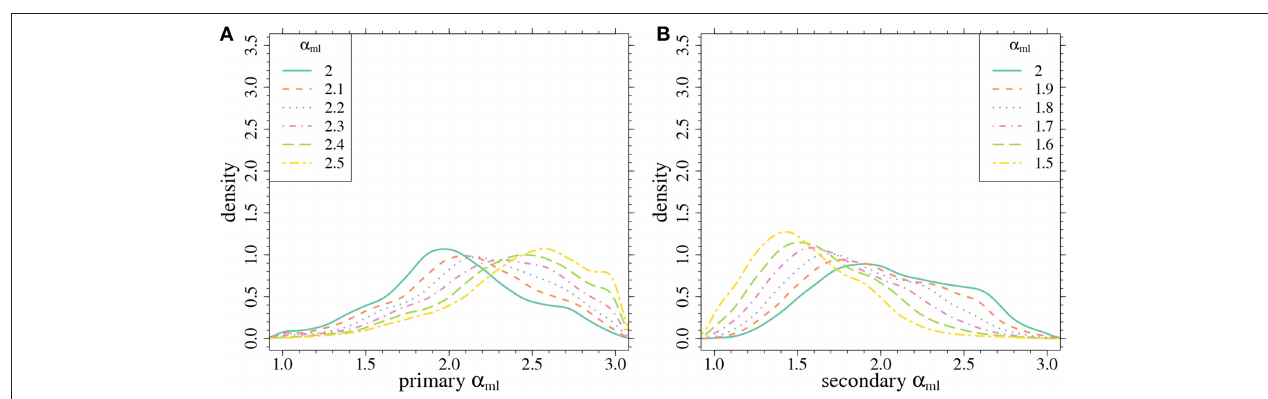
FIGURE 2 | (A) : density of probability of mixing-length value estimates for the primary star, for the independent stellar fit. Different line styles identify the α ml values from (2.0 to 2.5) adopted in the sampling of the mock data. (B) : same as in the (A) panel, but for the secondary star. The sampling α ml values for the secondary star run from 2.0 to